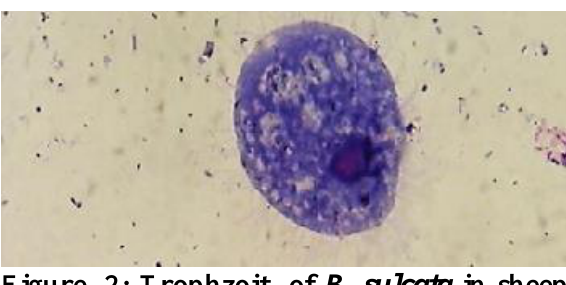
Figure,1: Trophozoite of B. sulcata in sheep drinking water in direct wet film (100x).